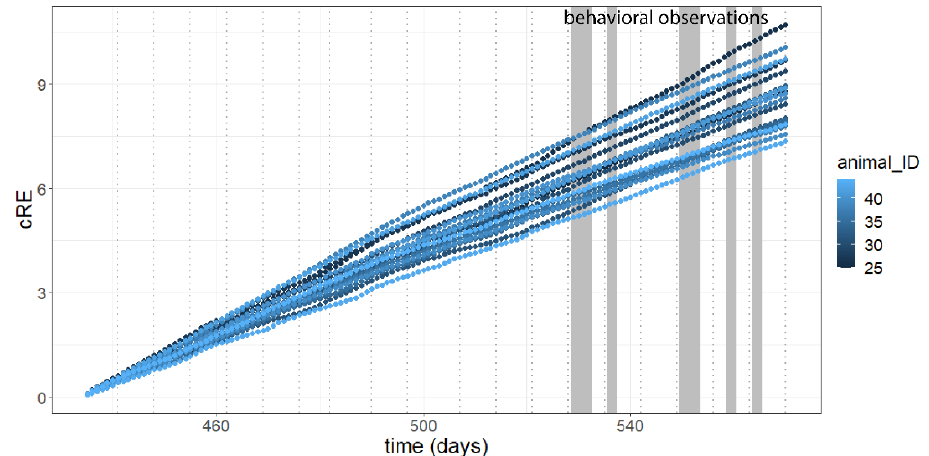
Figure 6. Cumulative roaming entropy (cRE) for 19 mice in the SNE over time. Vertical dotted lines indicate the weekly cleaning of the cage. Vertical grey areas indicate behavioral observations.